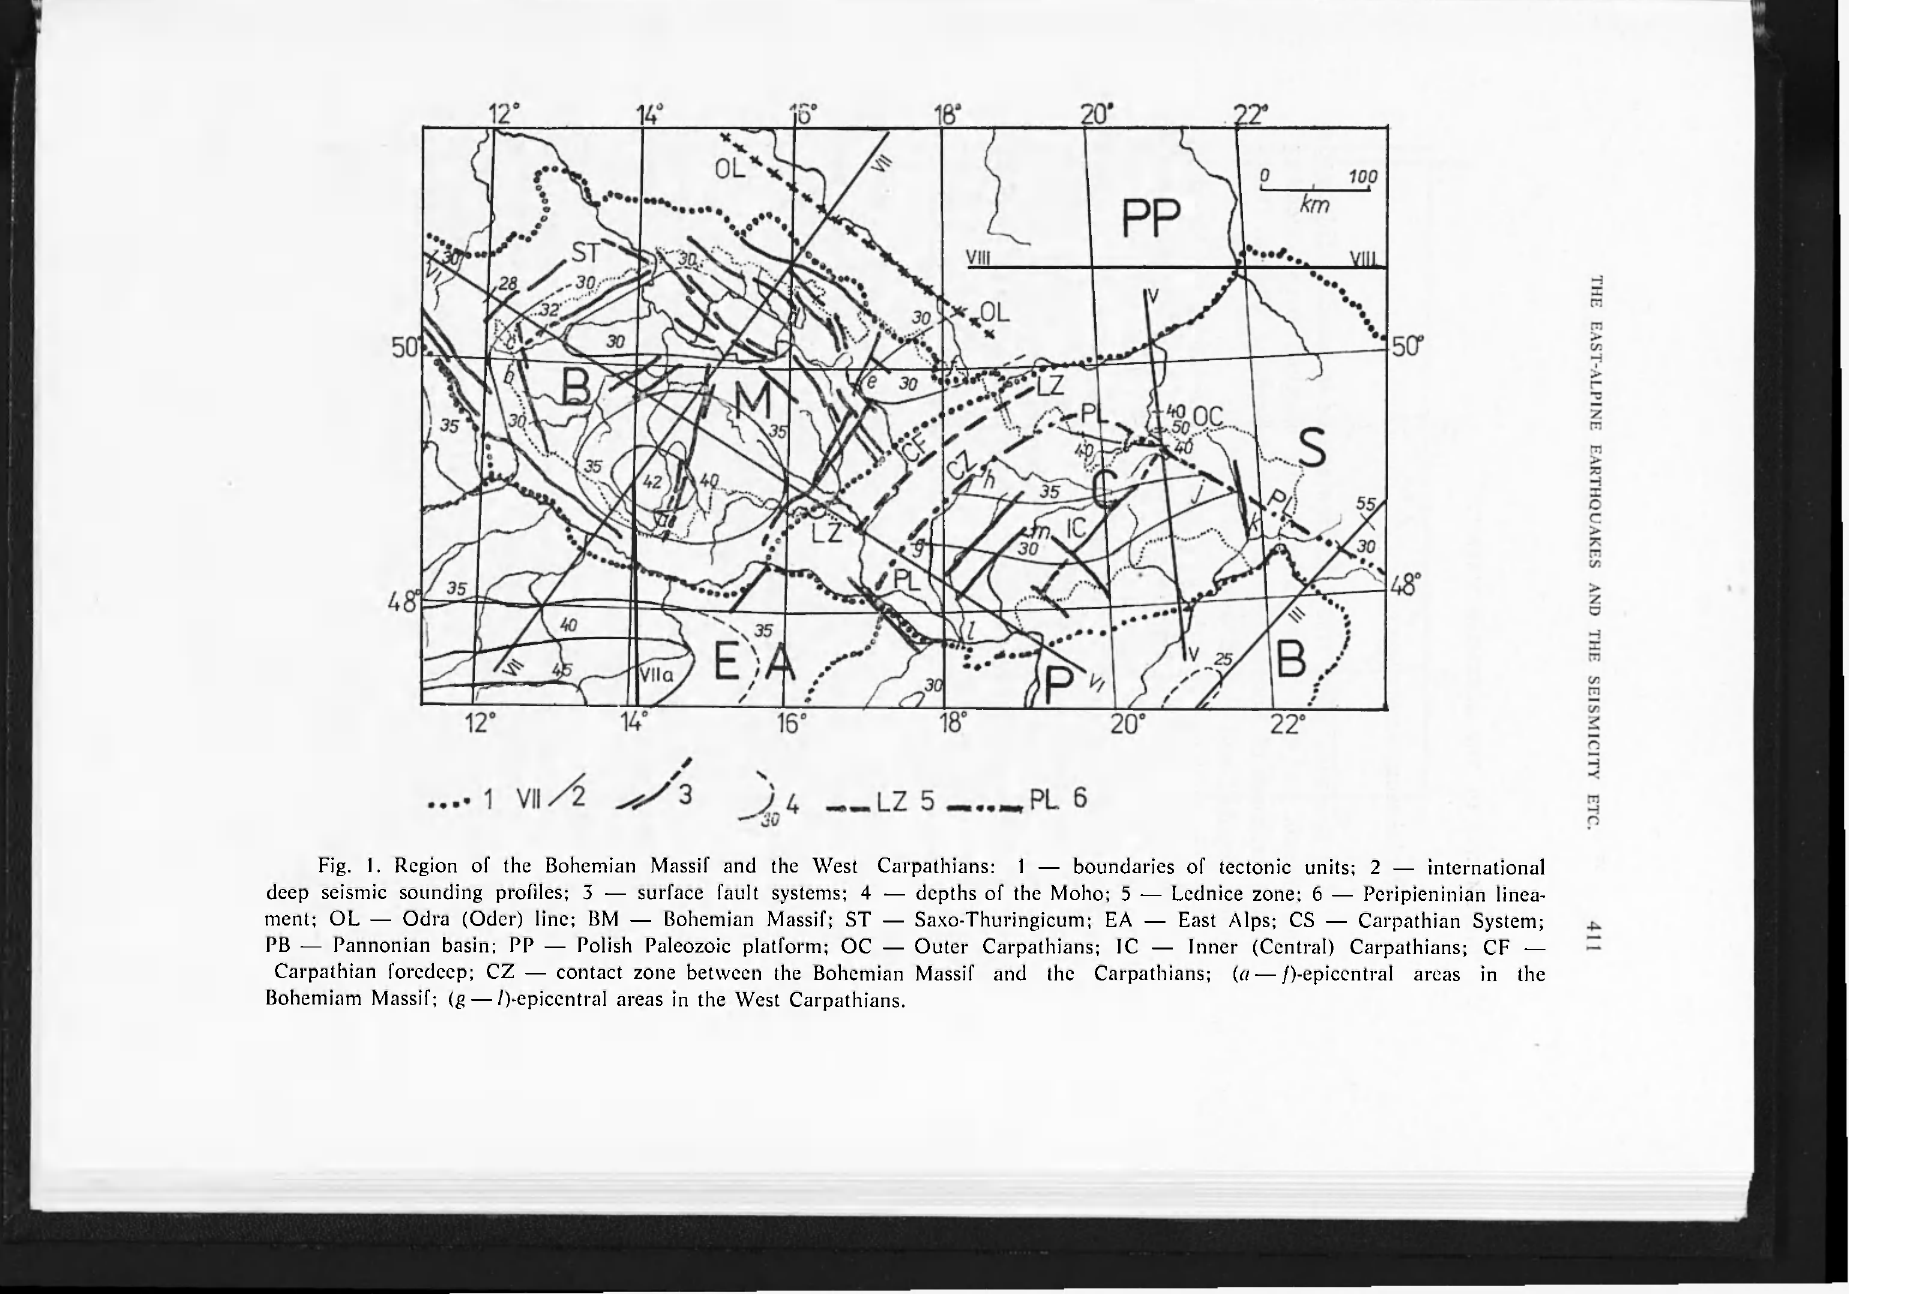
Fig. 1. Region of the Bohemian Massif and the West Carpathians: 1 — boundaries of tectonic units; 2 — international deep seismic sounding profiles; 3 — surface fault systems; 4 — depths of the Moho; 5 — Lednice zone: 6 — Peripieninian linea- ment; OL — Odra (Oder) line; BM — Bohemian Massif; ST — Saxo-Thuringicum; EA — East Alps; CS — Carpathian System; PB — Pannonian basin; PP — Polish Paleozoic platform; OC — Outer Carpathians; IC — Inner (Central) Carpathians; CF — Carpathian foredeep; CZ — contact zone between the Bohemian Massif and the Carpathians; (a — /)-epicentral areas in the Bohemiam Massif; (g — /)-epicentral areas in the West